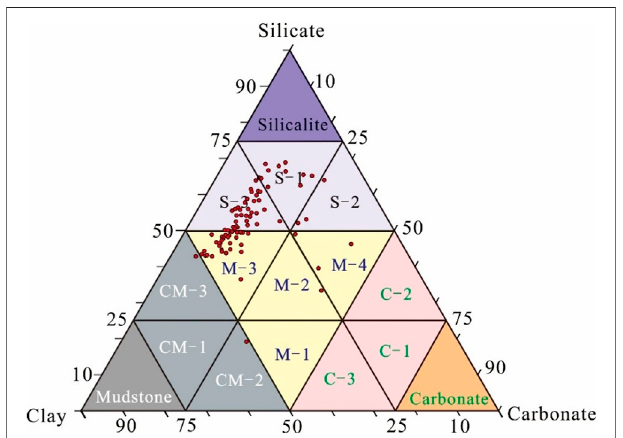
FIGURE 5 | Lithofacies ternary diagram of the Longmaxi shale in the Changning area. S-1 is mixed siliceous shale, S-2 is calcareous siliceous shale, S-3 is argillaceous siliceous shale; M-1 is argillaceous-calcarous mixed shale,M-2ismixedshale,M-3issiliceous-argillaceousmixedshale,M-4 issiliceous-calcareousmixedshale;CM-1ismixedargillaceousshale,CM-2is calcareous argillaceous shale, CM-3 is siliceous argillaceous shale; C-1 is mixed calcareous shale, C-2 is siliceous calcareous shale, and C-3 is argillaceous calcareous shale.